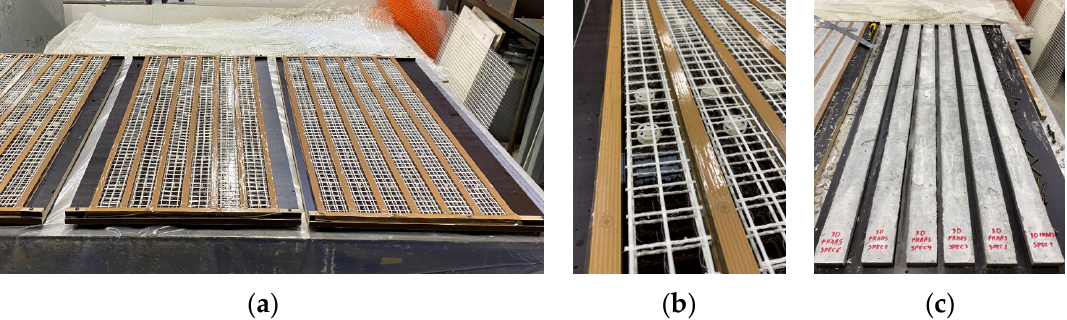
Figure 5. The specimen manufacturing process: ( a ) view of the molds with textiles; ( b ) zoom with visible connections; ( c ) specimens after demolding.